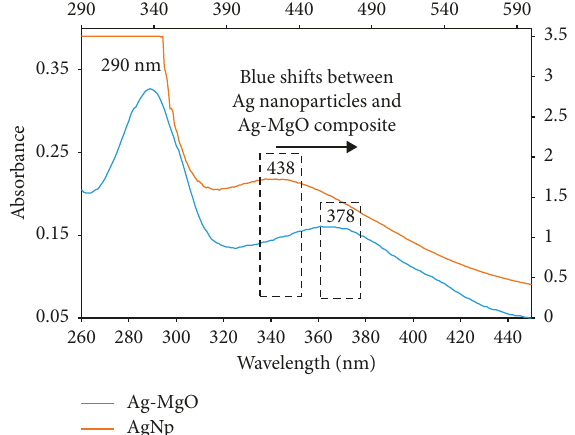
Figure 2: UV-visible spectra of biomolecular capped Ag-MgO nanocomposite.